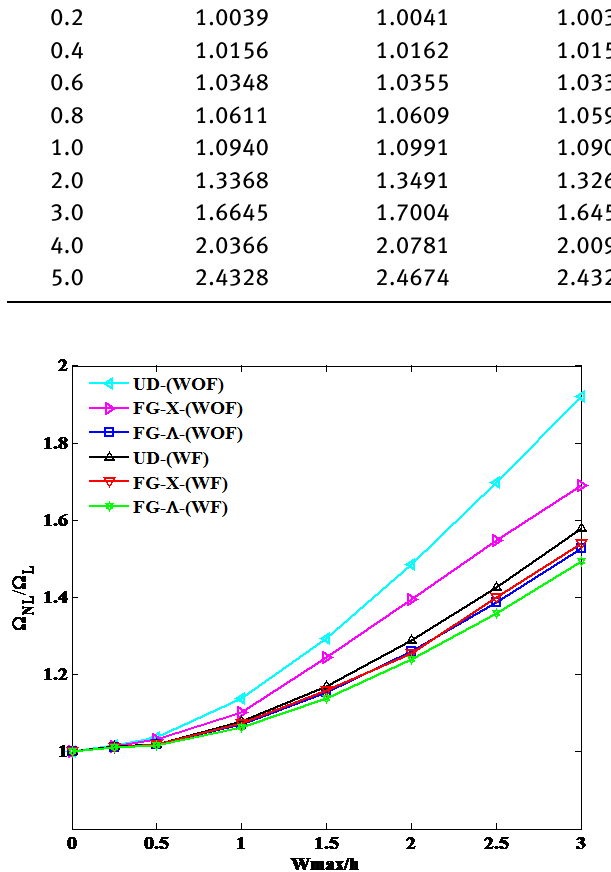
Figure 3: The effect of foundation stiffness on the amplitude –frequency curves of three types of CNTRC beam at a / h =